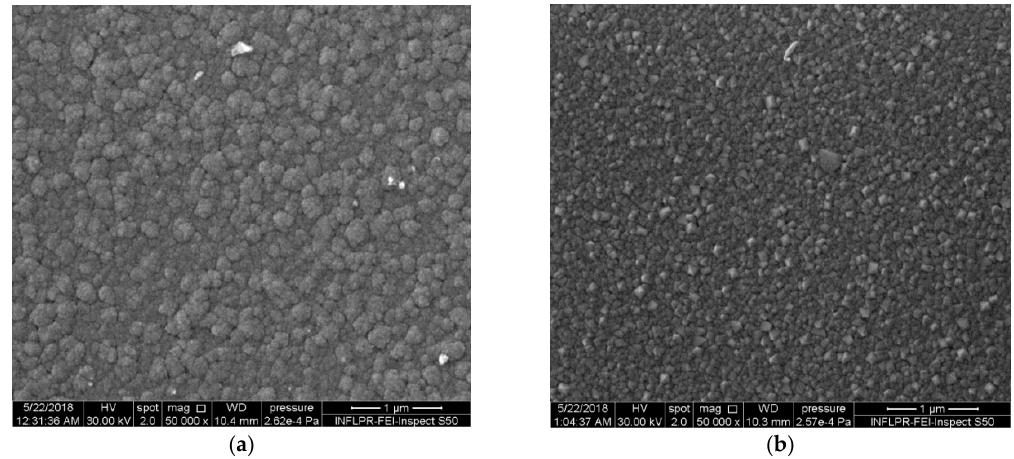
Figure 2. SEM images of the surfaces of WO 3 thin films deposited in 150 mTorr O 2 at different substrate temperatures. ( a ) 300 °C, ( b ) 600 °C.